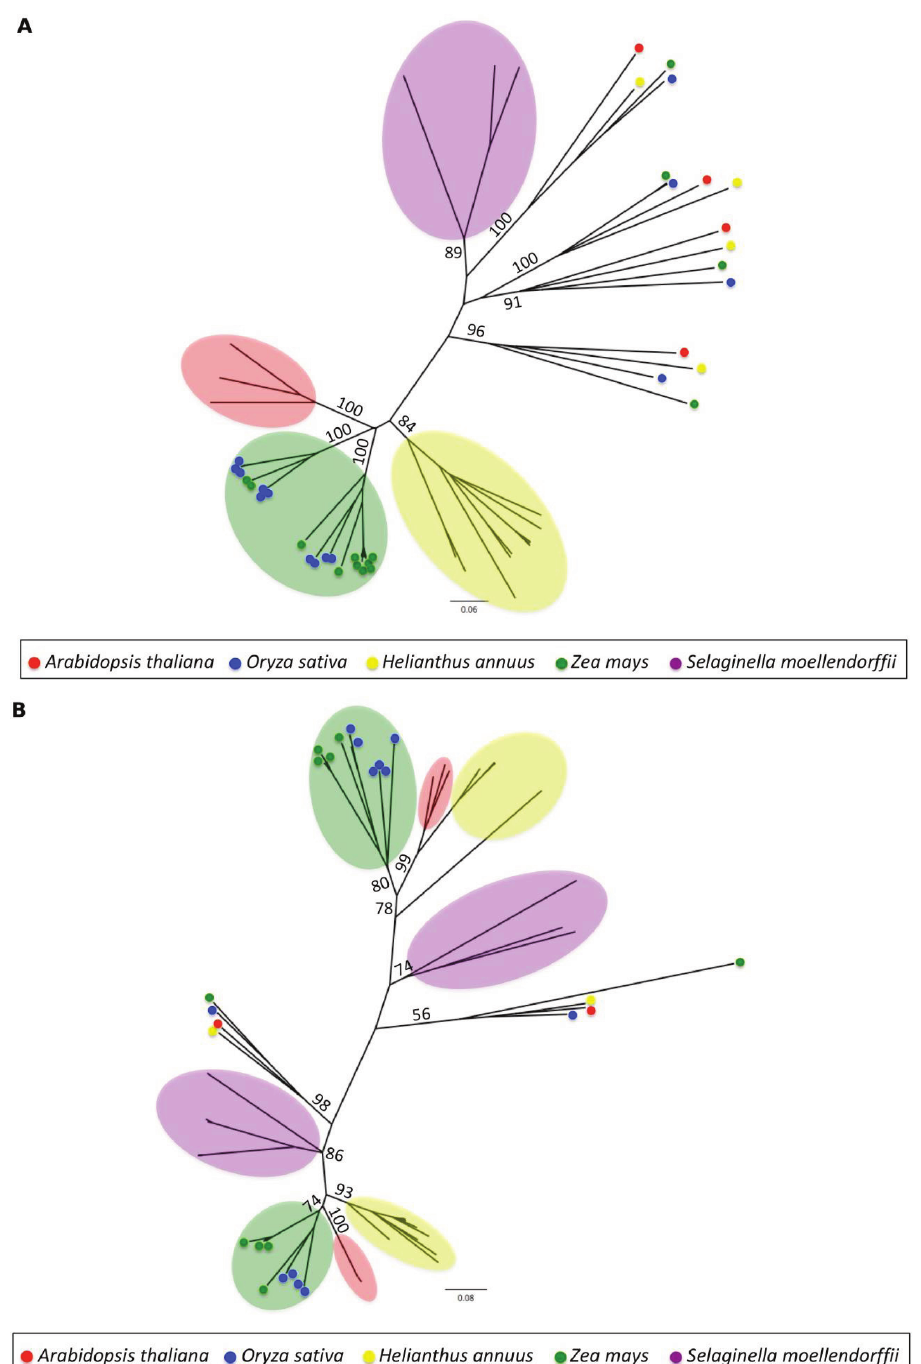
Figure 3. 1000 bootstrap Neighbor-Joining tree of ( a ) Ty1-Copia and ( b ) Ty3-Gypsy elements from different species. The evolutionary history was inferred using the Neighbor-Joining method [75]. The optimal tree with the sum of branch length = 8.7 is shown. The trees are drawn to scale, with branch lengths in the same units as those of the evolutionary distances used to infer the phylogenetic tree. The evolutionary distances were computed using the Poisson correction method [74] and are in the units of the number of amino acid substitutions per site. The analysis involved 75 Ty1-Copia and 110 Ty3-Gypsy sequences. All ambiguous positions were removed for each sequence pair. There were a total of 250 positions in the final dataset. Evolutionary analyses were conducted in MEGA5